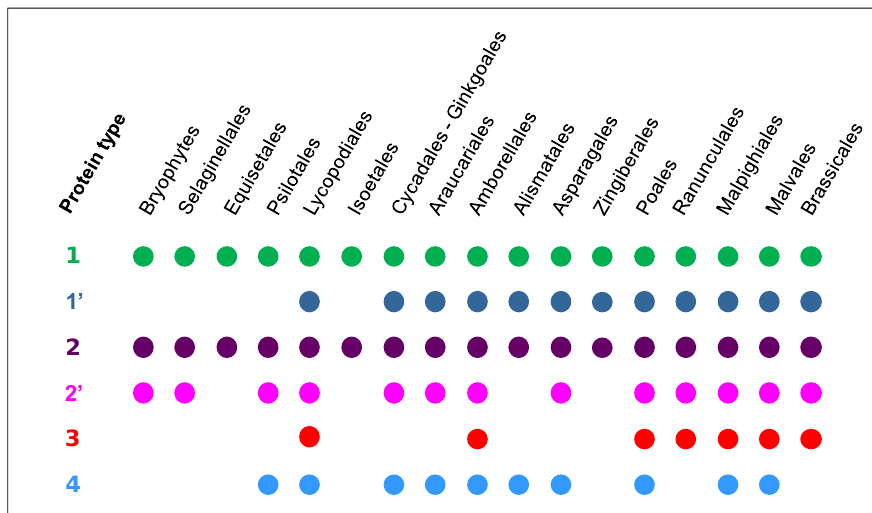
Figure 4. Distribution of the different types of PAC domains within the plant families. The different types of PAC domains are represented in Figure 2. Among type 1-PAC domains, those having a highly conserved amino acid sequence are distinguished (1 ’ ). Among type 2-PAC domains, those that are associated to a C-terminal W-W domain are highlighted (2 ’ ).